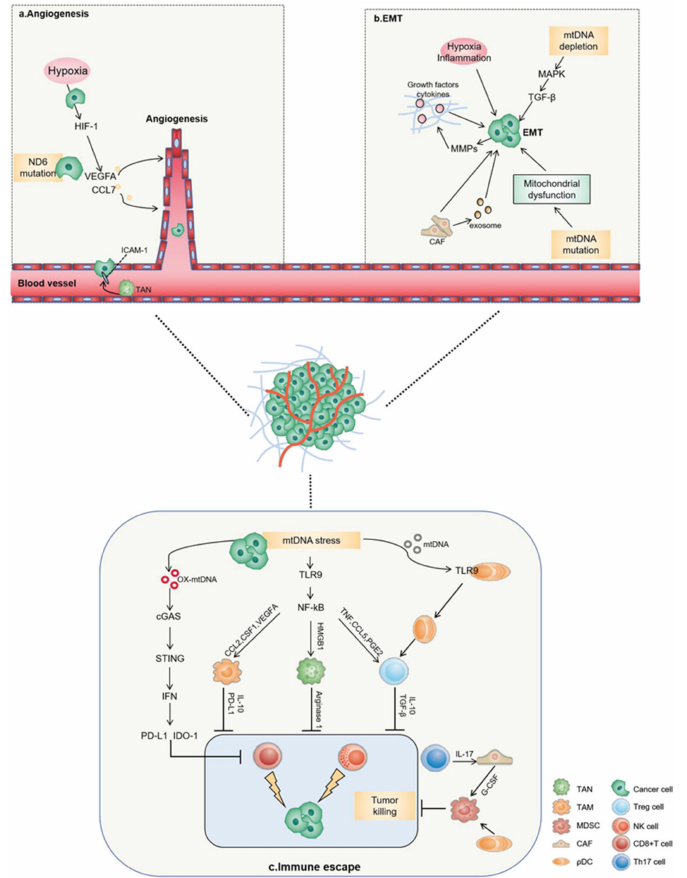
Figure 3. The association between mtDNA and tumor metastasis. ( a ) Angiogenesis is a rate-limiting factor in tumor growth. Cancer cells carrying the 13885insC mutation of the ND6 subunit have higher spontaneous metastasis potential. A PCR array analysis showed higher levels of VEGF, CCL7 and other metastasis-associated genes. The increase in VEGF and CCL7 levels is obviously an important factor in stimulating tumor blood vessel growth to promote tumor cell invasion, migration and infiltration. ( b ) EMT is a process in which the epithelial tumor cells lose adhesion ability and cause the migration of mesenchymal cells to promote metastasis and drug resistance. The mtDNA depletion can lead to a loss of characteristic epithelial cell features and to a mesenchymal phenotype being gained. The RAF/MAPK signaling pathway is highly activated and accompanied by the expression of TGF- β . The above suggest that the tumor cells acquire higher invasiveness. The mutations of mtDNA may be accompanied by decreased respiratory enzyme complex activity and mitochondrial dysfunction, which leads to the malignant phenotype of the tumor. ( c ) Tumor immune escape is a critical step in tumor metastasis and malignant progression. Oxidized mtDNA can be released into the cytoplasm, which induces IFN signals through cGAS-STING-TBK1, thereby upregulating the expression of PD-L1 and IDO-1 to inhibit the activation of T cells. It has been reported that mtDNA stress in HCC cells with increased mitochondrial division significantly increases CCL2 production by activating the TLR9-mediated NF- κ B signaling pathway, thereby promoting TAM recruitment and polarization and consequently promoting tumor progression. Mitochondrial DAMP (including mtDNA) can activate neutrophils to generate NETs, which have been shown to promote cancer- related formation and are associated with accelerated metastasis. Immature pDC can recognize the CpG sequence on mtDNA through TLR9, and can induce the production of CD4 + CD25 + Treg cells after activation and maturation. Treg cells secrete cytokines IL10 and TGF- β , which produce powerful immunosuppressive